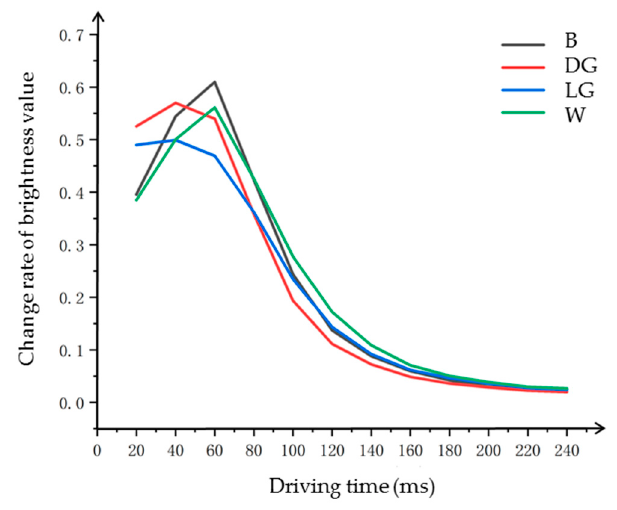
Figure 4. First order derivative curve of brightness value in improving particle activity phase . “B”, “DG”, “LG”, and ”W” indicate different initial grayscale in the driving waveform.